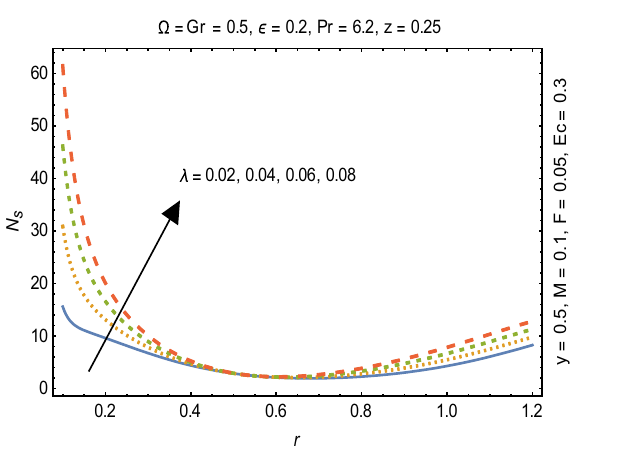
Figure 9. Variation in N s for (cid:31) .